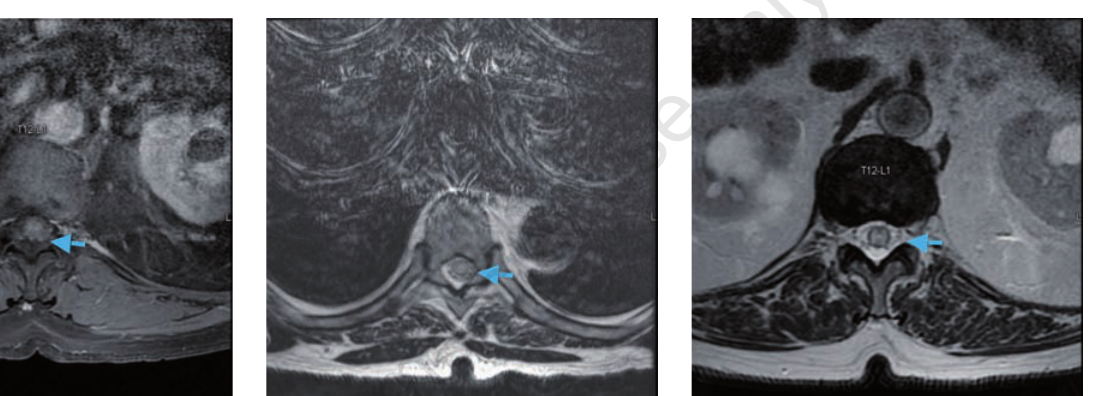
Figure 1. Sagittal T2-weighted image of the thoracic spine demonstrate hyper intense T2 signal abnormality within the central area of the thoracic spinal cord extending from T6 to the conus medullaris. Multiple intradural flow voids are noted (arrows).